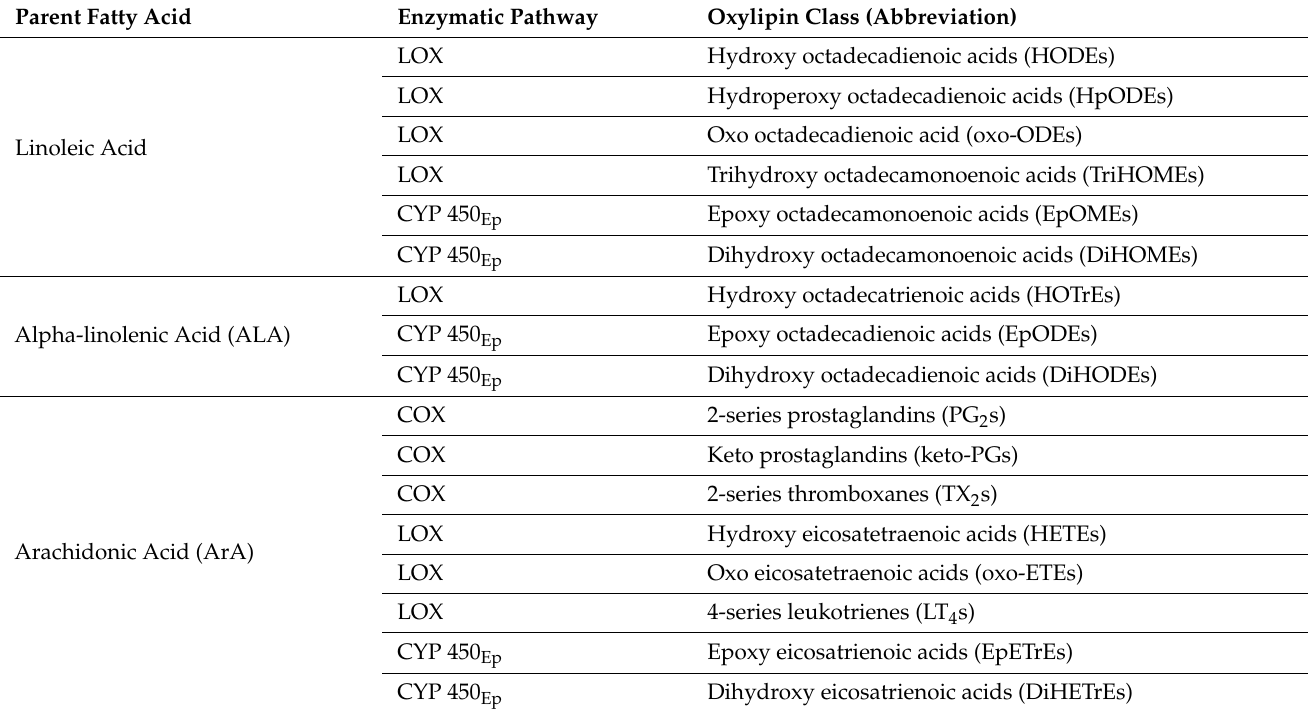
Table 1. Cyclooxygenase (COX), lipoxygenase (LOX), and cytochrome P450 epoxygenase (CYP 450 Ep ) pathway oxylipins by parent fatty acid as discussed in this